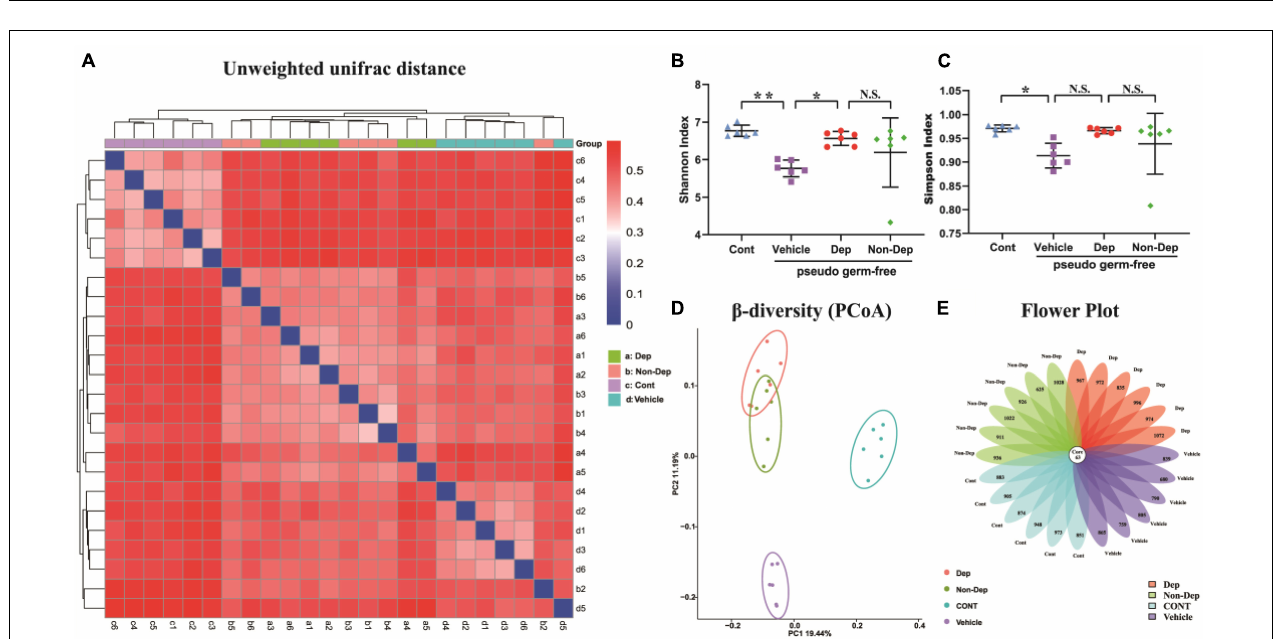
FIGURE 8 | Effects of fecal microbiota transplantation on depression-like behaviors in pseudo-germ-free rats. (A) SPT. (B) FST. Data are shown as mean ± SEM. ( n = 6) by one-way ANOVA, ** p < 0.01, *** p < 0.001, or **** p < 0.0001; N.S., not significant. SPT, sucrose preference test; FST, forced swimming test; Cont, control; Dep, depression-like behavior; Non-Dep, non-depression-like behavior.